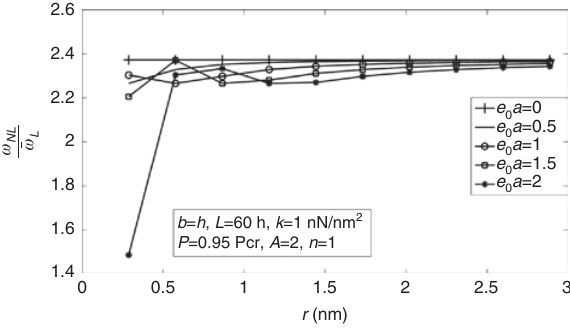
Figure 9: Effect of radius of gyration and small-scale parameter on the nonlinear to linear fundamental frequency